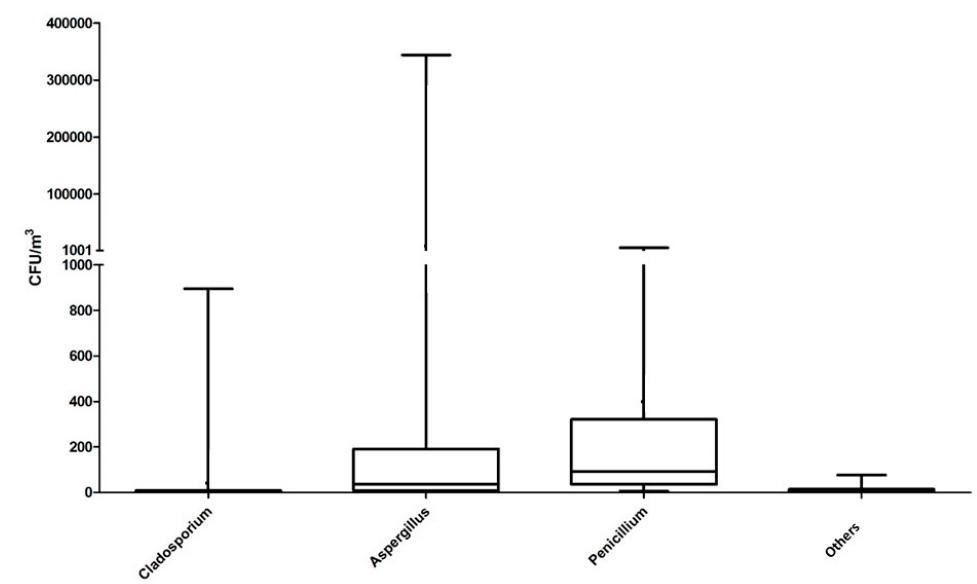
Figure 2. Representation of the fungal groups ( Cladosporium , Aspergillus , Penicillium and others) quantified from bioaerosols. The box and whisker plots show the median percentage of fungal concentration (horizontal bars), their quartiles (box) and range (whiskers).